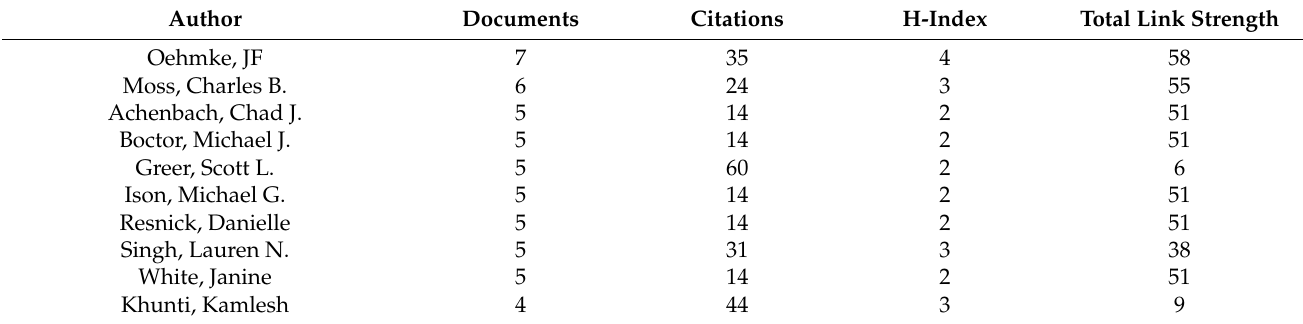
Table 6. The top 10 productive